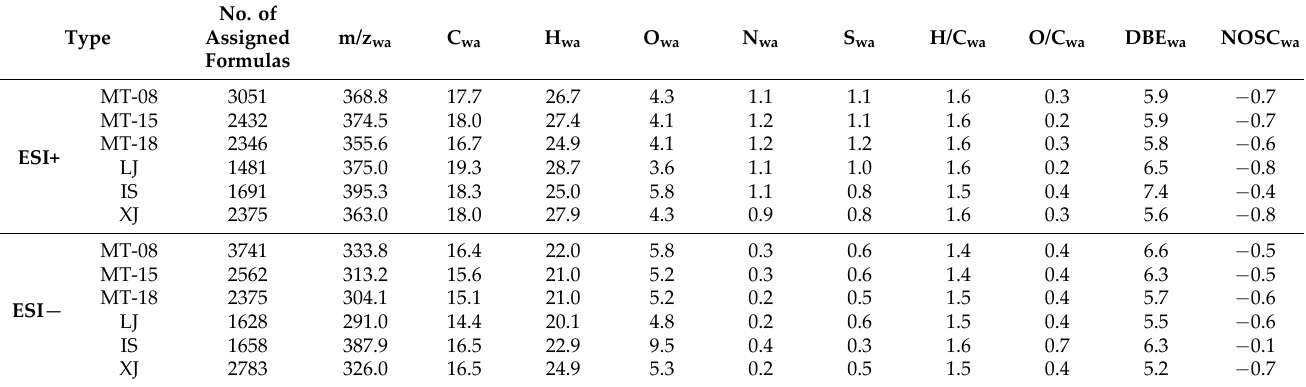
Table 1. Molecular parameters of trace components in Baijiu derived from ESI FT‑ICR MS